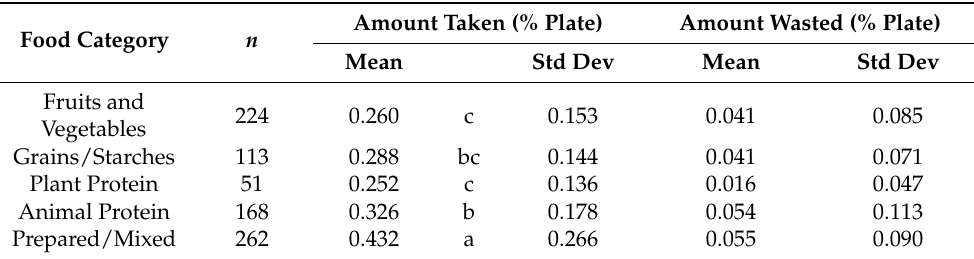
Table 3. Means and standard deviations were calculated for each food category for the amount taken and wasted in the percentage of the plate. The number of responses for each category is also listed. Different letter means sharing superscript letters were not significantly different as per Fisher’s LSD ( p <